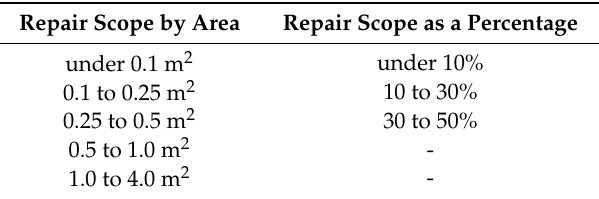
Table 6. Division of repairs of thin plaster and types of